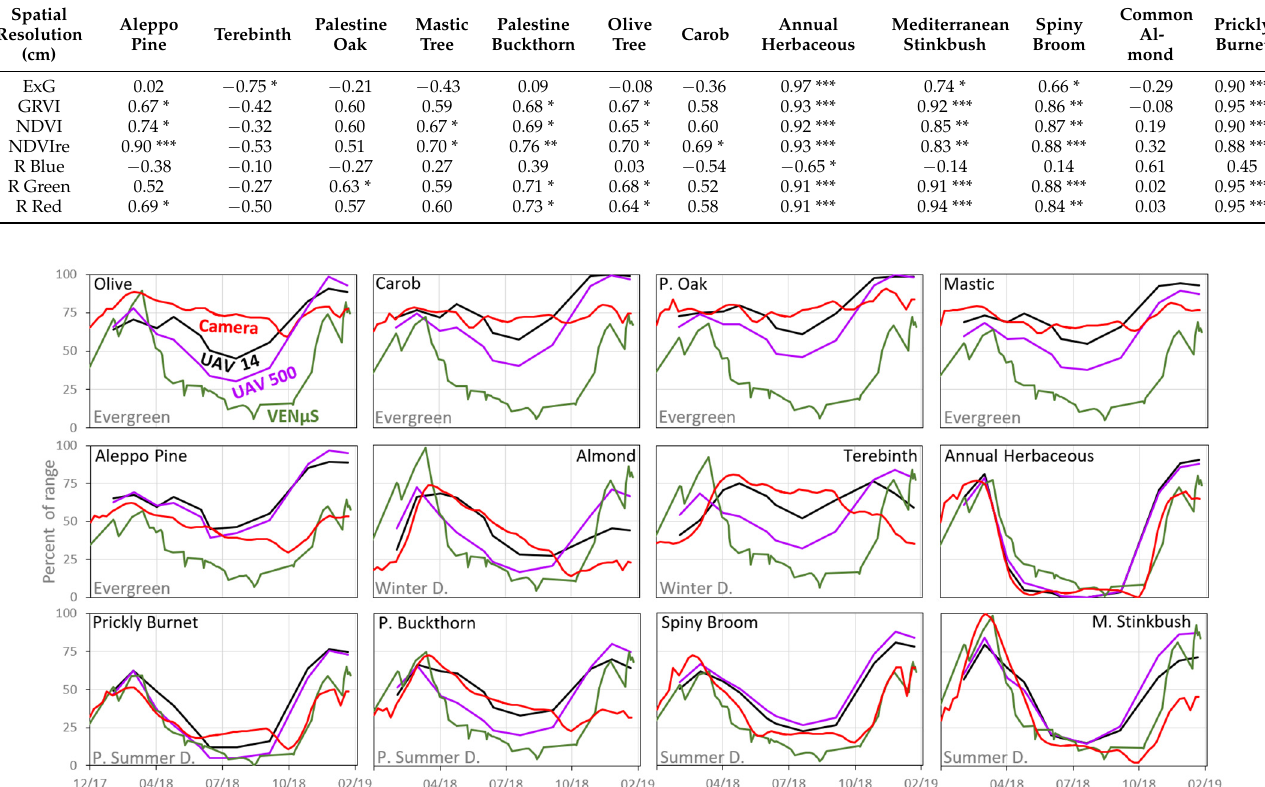
Table 5. Pearson correlation coefficients of seven spectral indices mean value for each species per date (10 dates), between values derived from the UAV data and those from VEN µ S. The asterisks indicate the statistical significance as follows: